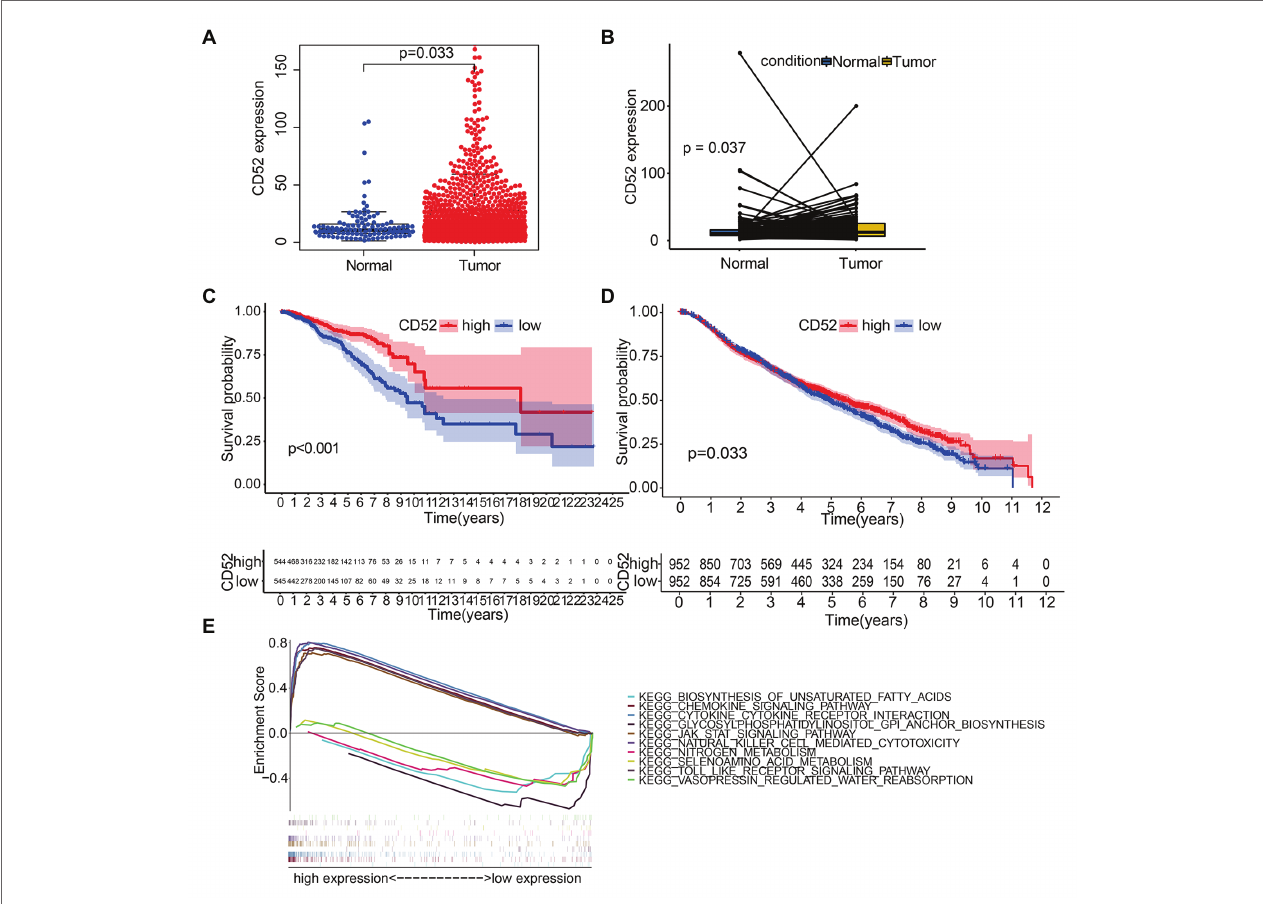
FIGURE 4 | The differentiated expression of CD52, correlation with the survival of BC patients, and gene set enrichment analysis (GSEA). (A) Differentiated expression of CD52 in the normal and BC samples. (B) Paired differentiation analysis for expression of CD52. (C) Survival analysis for BC patients with different CD52 expressions in The Cancer Genome Atlas (TCGA) database. (D) Survival analysis for BC patients with different CD52 expressions in the METABRIC cohort. (E) The top five significant pathways of high and low expressions,